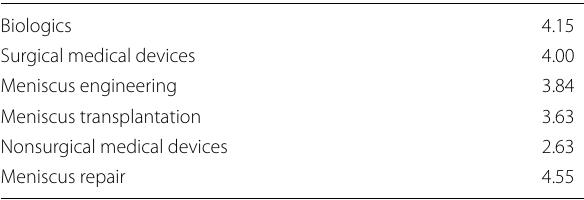
Table 1 Primary future research and development focus areas with weighted averages a